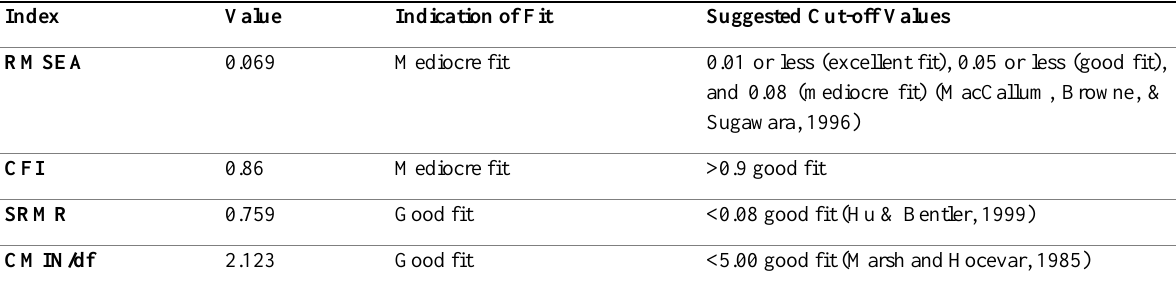
Table 12: Model Fit for Structural